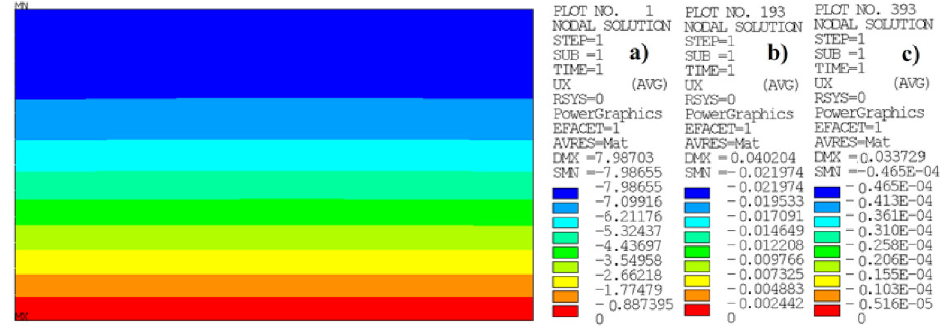
Figure 2. Pore pressure distribution and evolution at ( a ) 13.93, ( b ) 682.57, and ( c ) 1379.07 days.